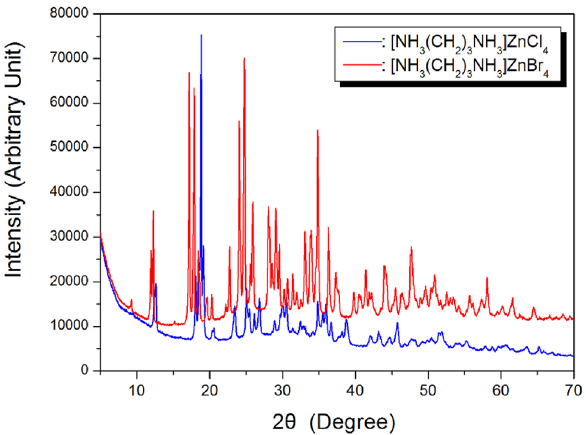
Figure 2. X-ray diffraction patterns of the [NH 3 (CH 2 ) 3 NH 3 ]ZnCl 4 and [NH 3 (CH 2 ) 3 NH 3 ]ZnBr 4 at 300 K.